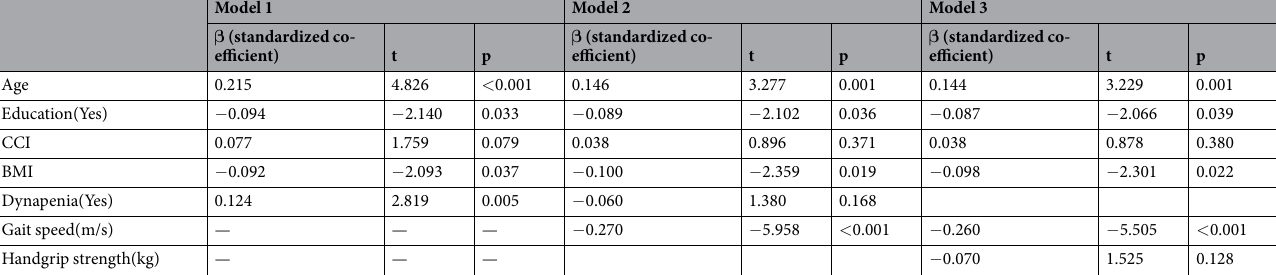
Table 2. Multiple linear regression analysis of risk factors for higher complexity of care needs * according to RAP triggers. * Higher complexity of care needs defined as ≥ 4 RAP triggers. CCI: Charlson’s comorbidity index; BMI: body mass index; RAP: Resident assessment protocol. Dynapenia: Based on Handgrip strength < 26kg. Model 1: Adjusted for Age, Educational level, CCI, BMI, and Dynapenia, R 2 = 0.088. Model 2: Adjusted for Age, Educational level, CCI, BMI, Dynapenia and Gait speed, R 2 = 0.160. Model 3: Adjusted for Age, Educational